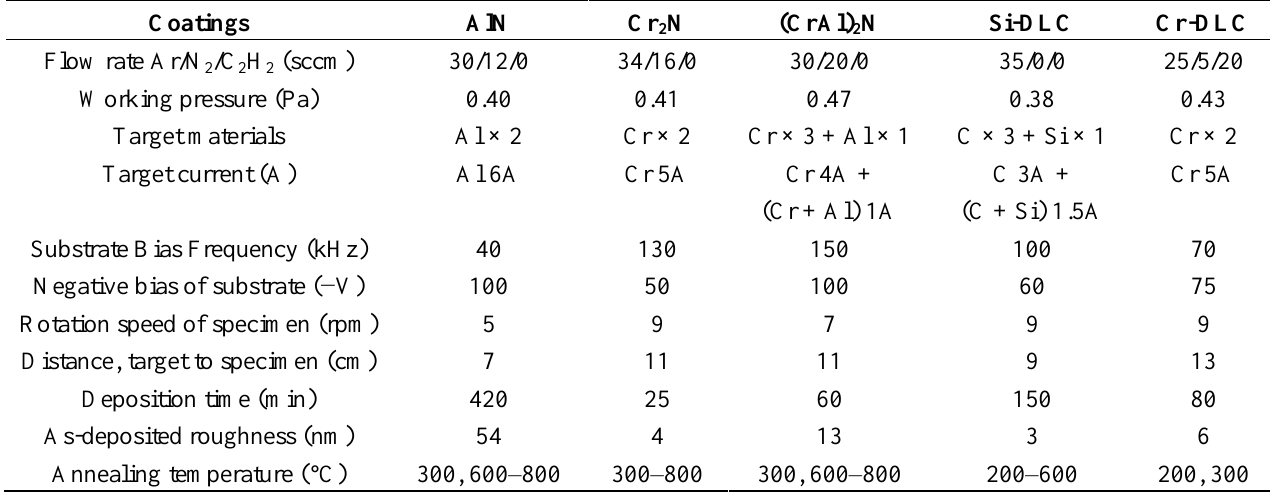
Table 1. Deposition parameters for various